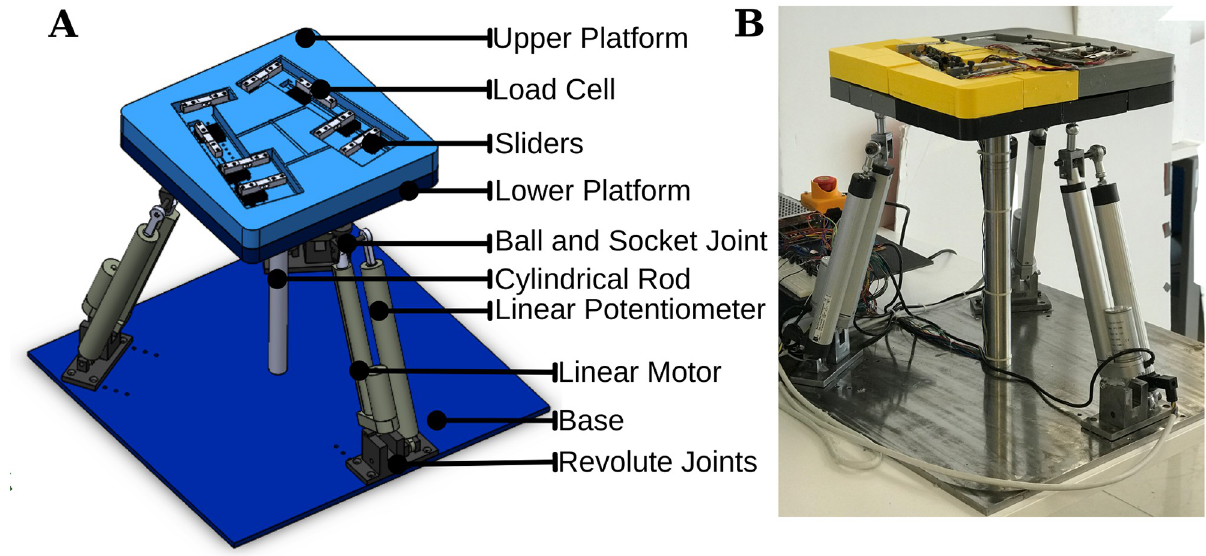
Fig 1. 3 DoF Robotic Platform (A) In the solid model, the main components of the system are presented (B) The first prototype of the design is presented.